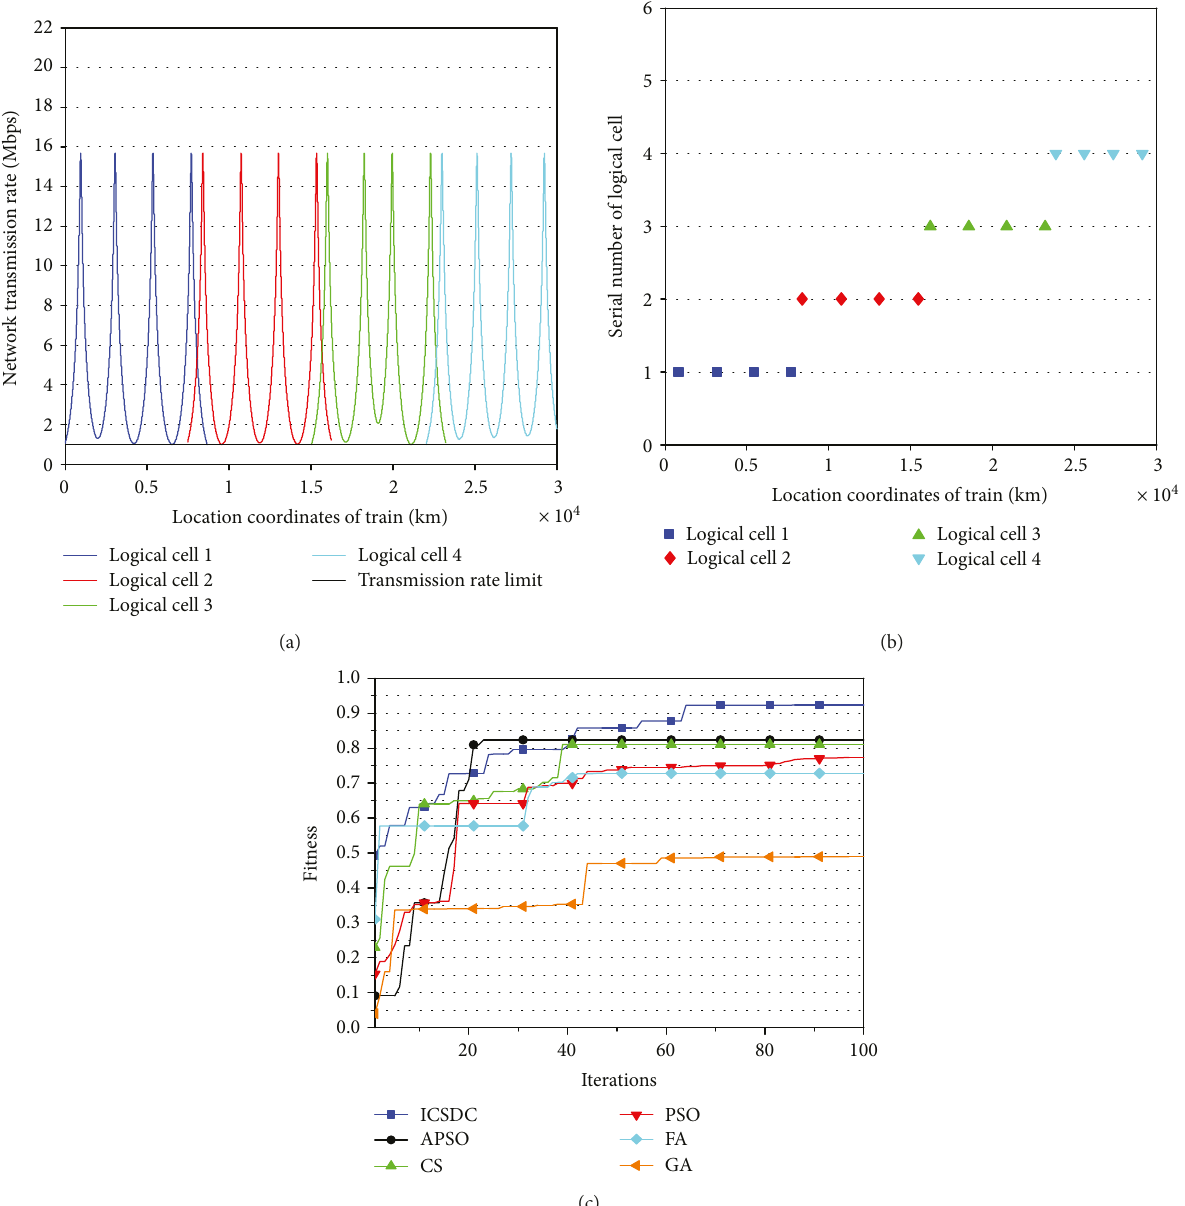
Figure 6: DAS deployment optimization results based on ICSDC algorithm: (a) network transmission rate along the railway, (b) DAS planning results, and (c) convergence rates of di ff erent algorithms for the